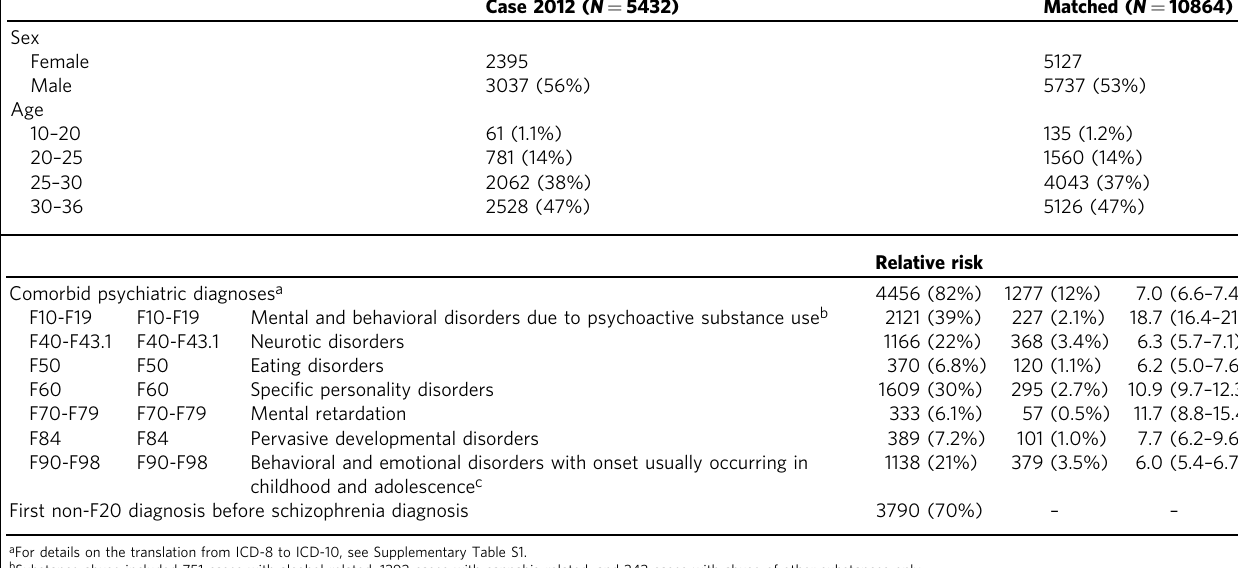
Table 1 Characteristics of the population-wide cohort of individuals with schizophrenia and the age and sex-matched controls.